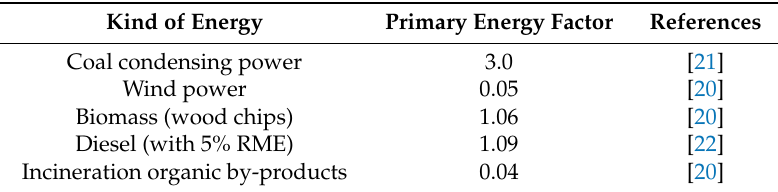
Table 1. Conversion factors for primary